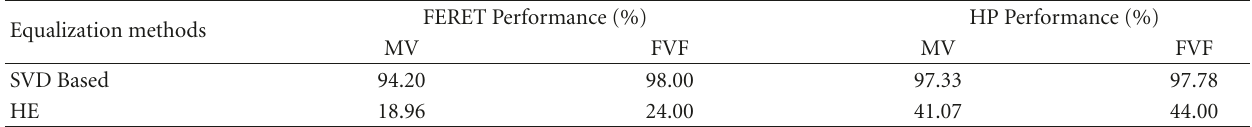
Table 7: Comparison of the proposed SVD based equalization with standard Histogram Equalization (HE) on the final recognition rates, where there are 5 poses in the training